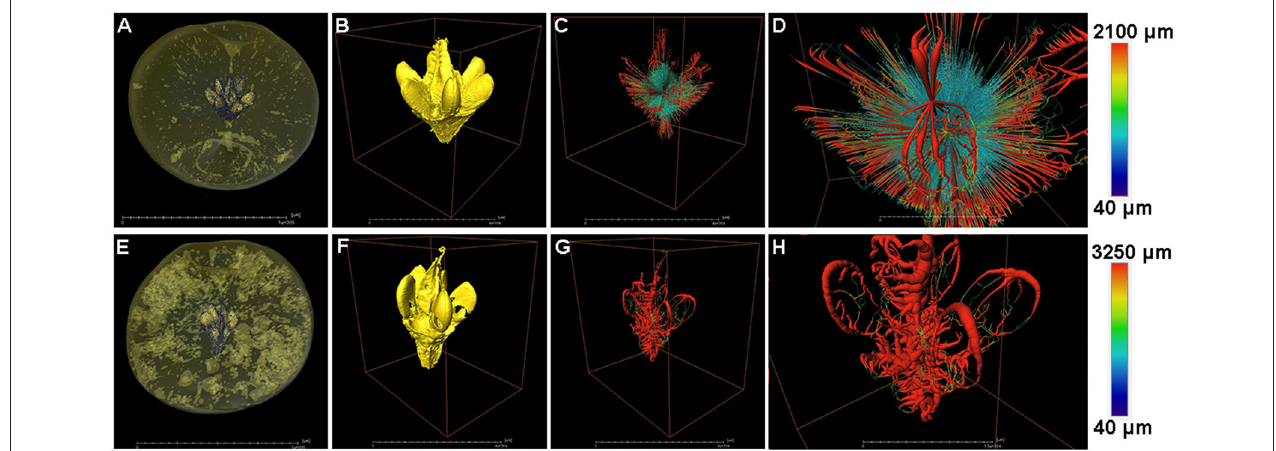
FIGURE 6 | Structure and network skeleton analysis of “Akizuki” fruit core. (A,E) Renderings of X-ray scanned healthy and cork spotted fruit, respectively, where the fruit core was distinguished by the grayscale values. (B,F) Reconstructed 3D model of the healthy fruit core and cork spotted fruit core, respectively. (C,G) Reconstructed 3D network model of (B,F) , respectively. (D,H) Closer view of (C,G) , respectively. Color bars on the right indicate pore thickness from narrow (blue) to wide (red).